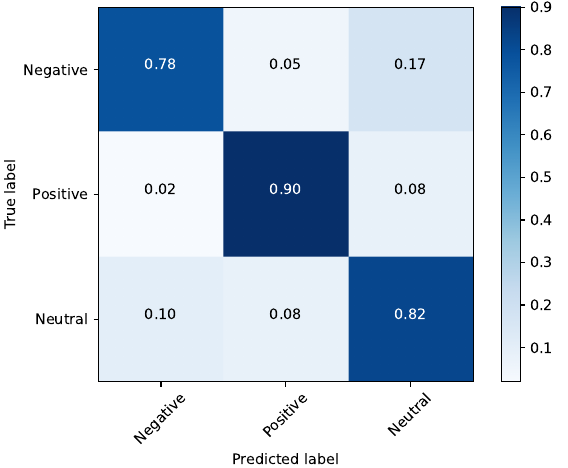
Figure 11. Training set (FER2013) and clustered emotions.